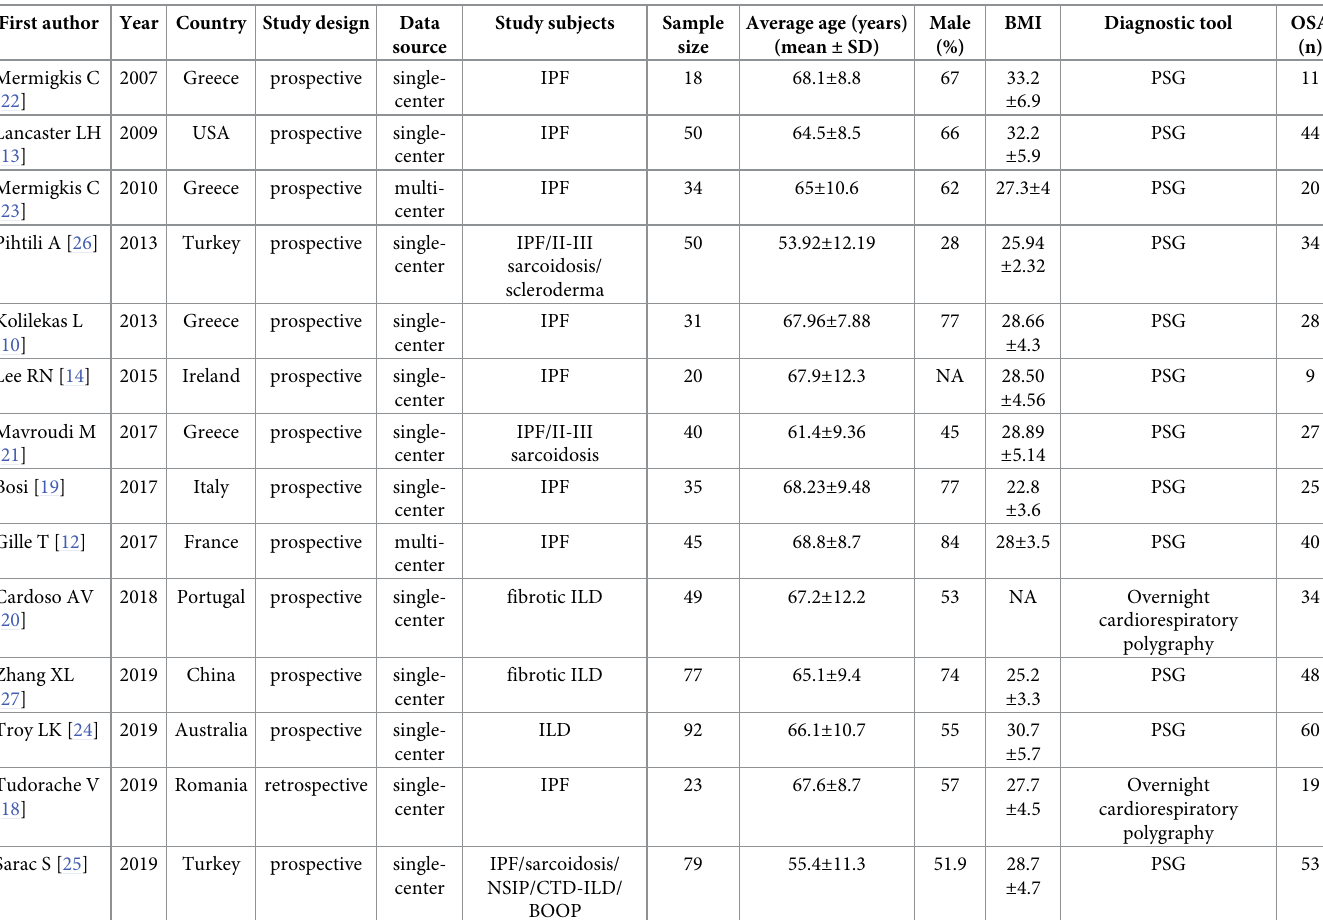
Table 1. Summary of eligible studies.